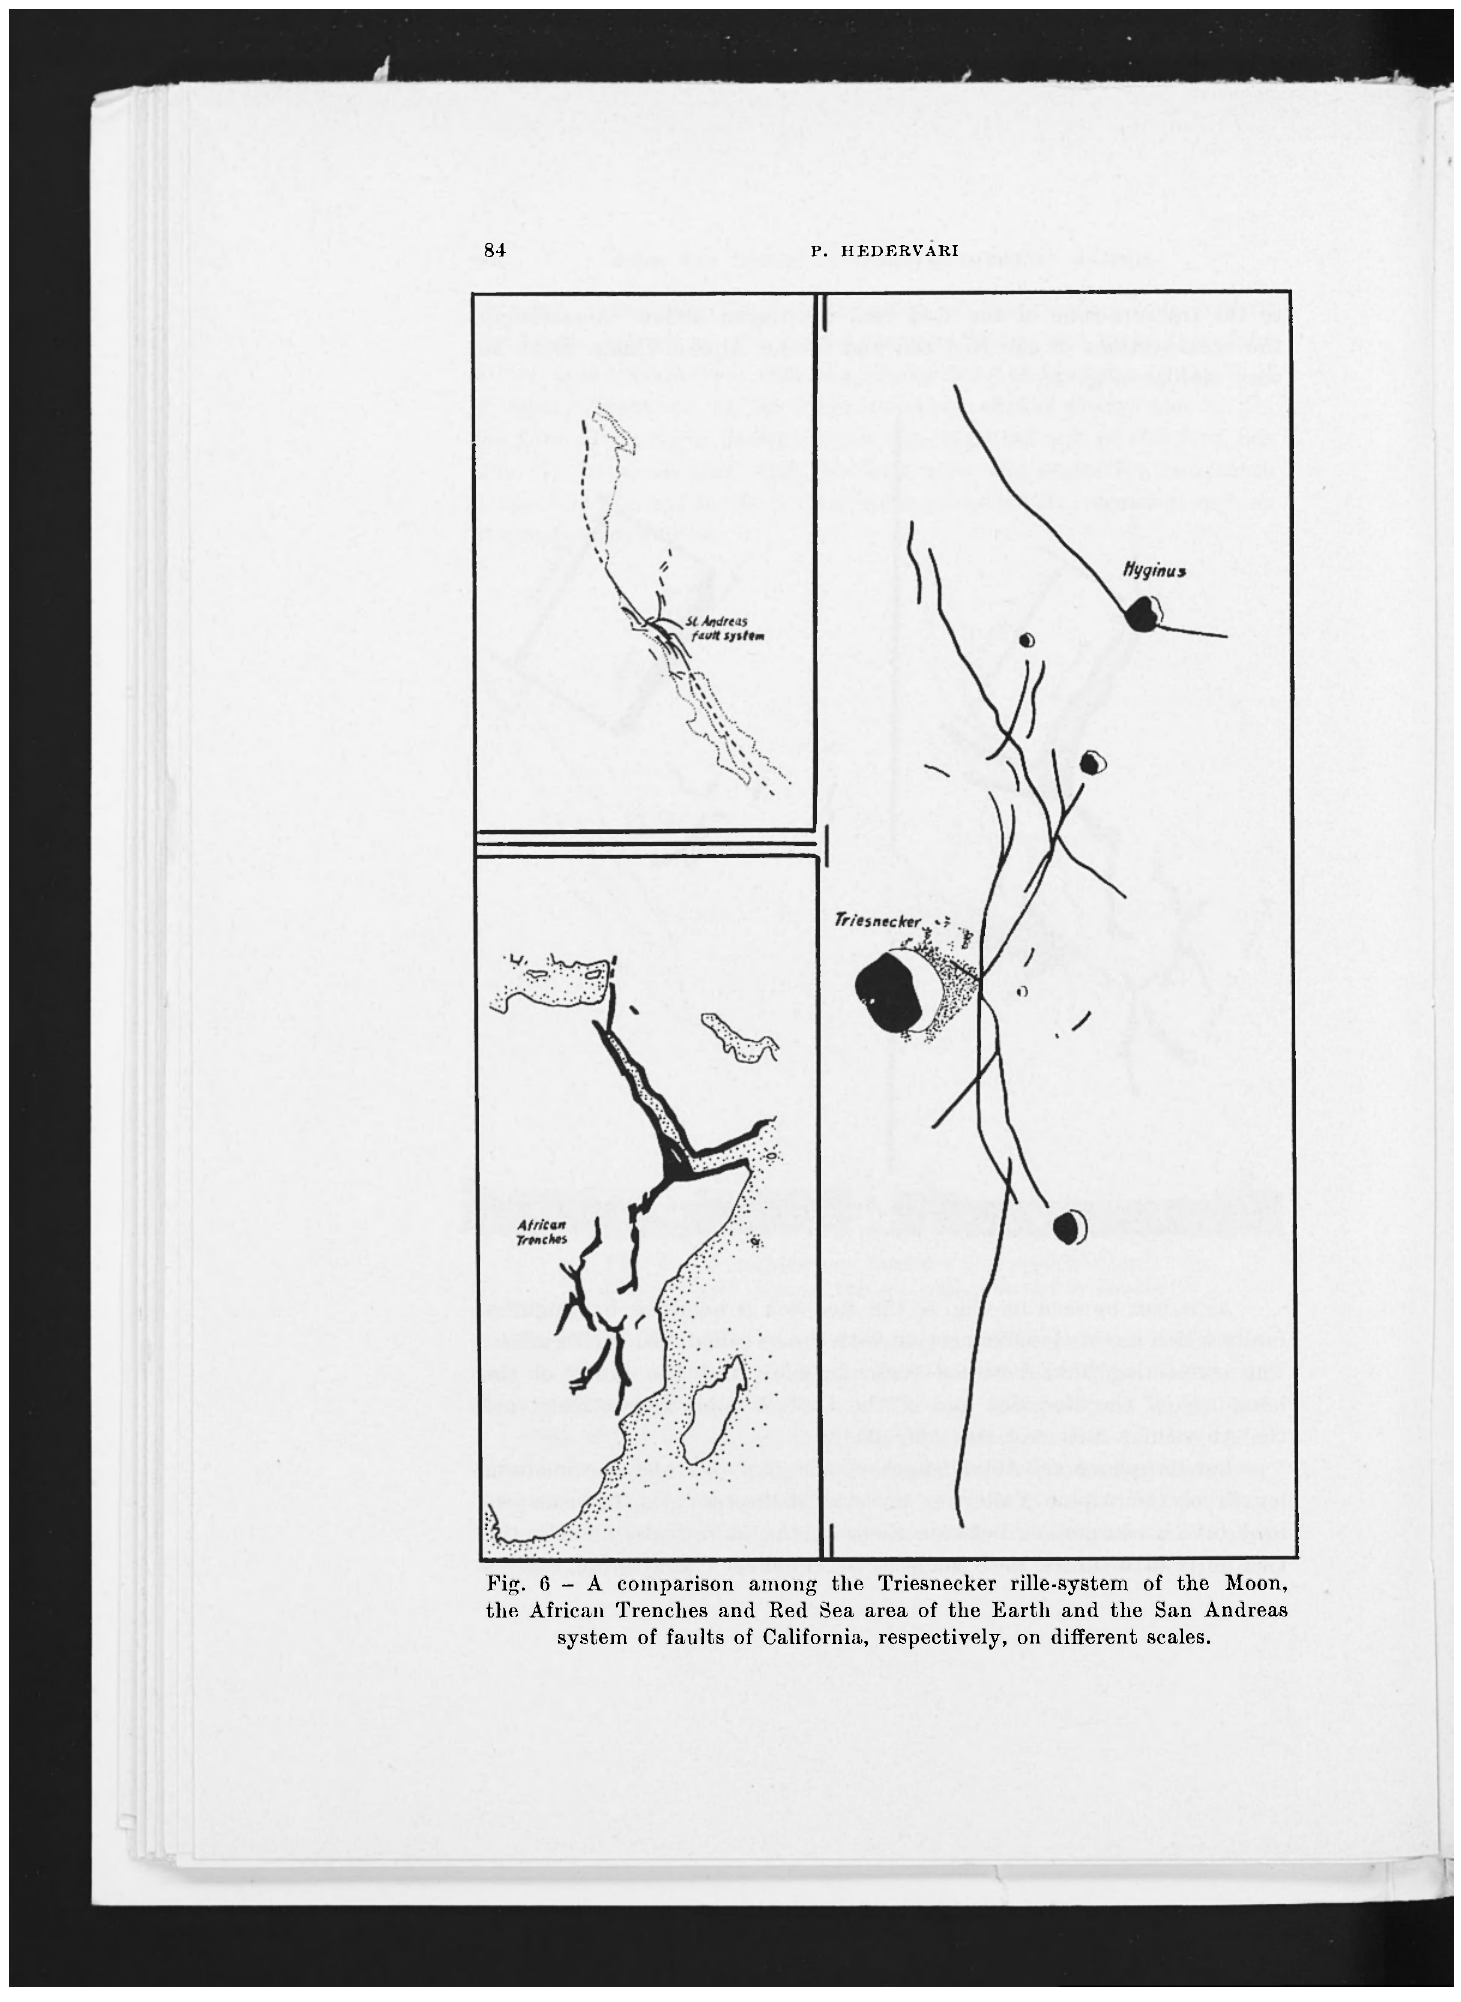
Fig. 6 - A comparison among the Triesnecker rille-system of the Moon, the African Trenches and Red Sea area of the Earth and the San Andreas system of faults of California, respectively, on different